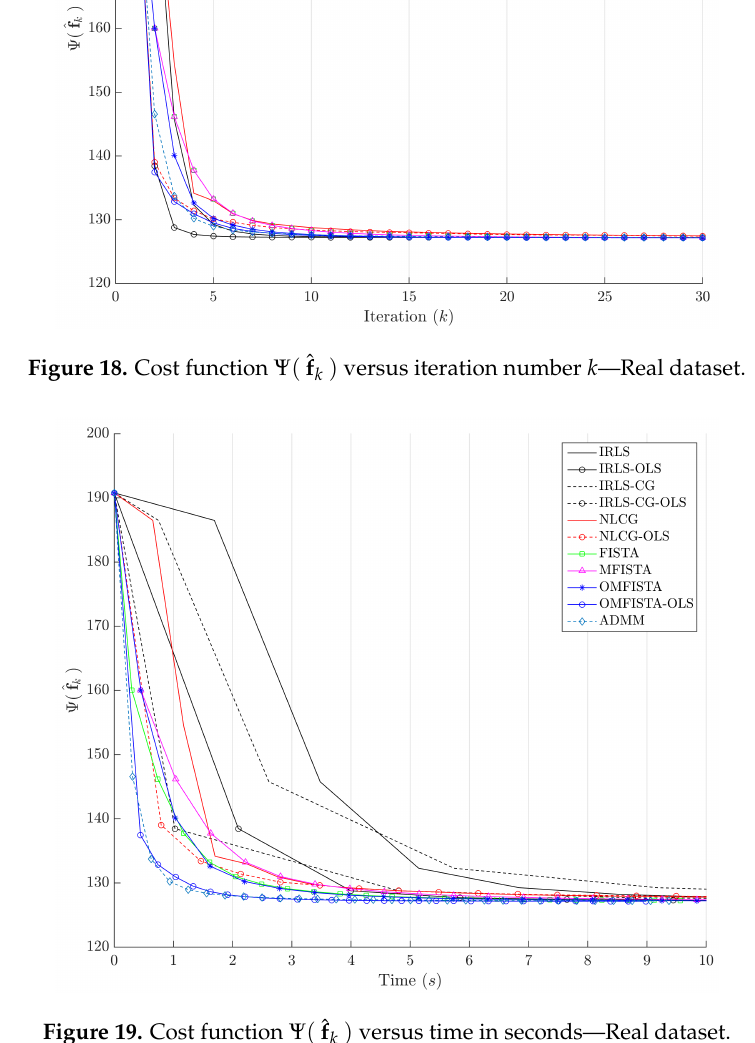
Figure 19. Cost function Ψ ( ˆ f k ) versus time in seconds—Real